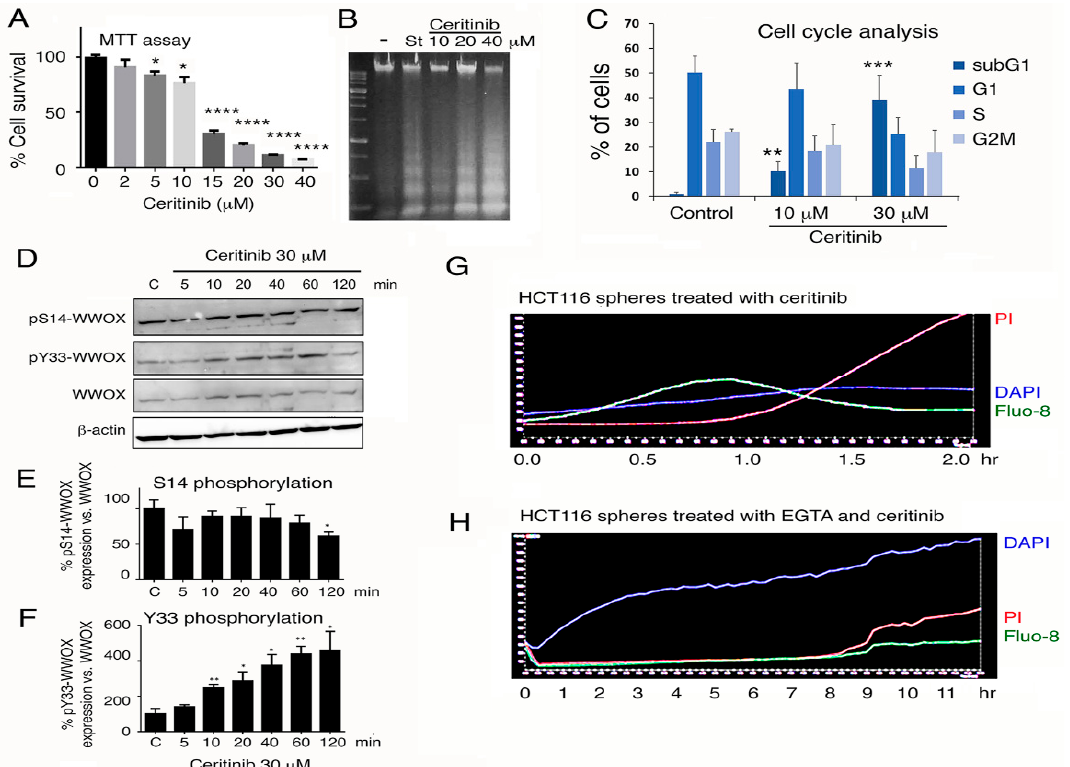
Figure6. Figure 6. Ceritinib induces 4T1 cell apoptosis by inducing calcium influx and upregulating pY33- WWOX. ( A – C ) 4T1 cells were treated with an indicated concentration of ceritinib for 24 h at 37 ℃ and